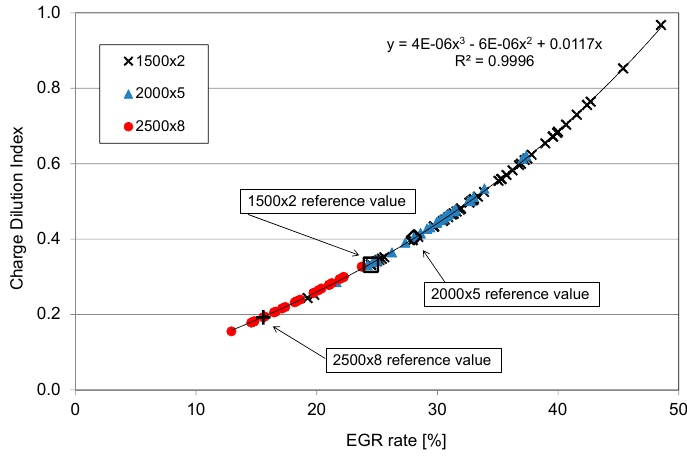
Figure 8. Relationship between EGR rate and charge dilution index in tested operating modes.